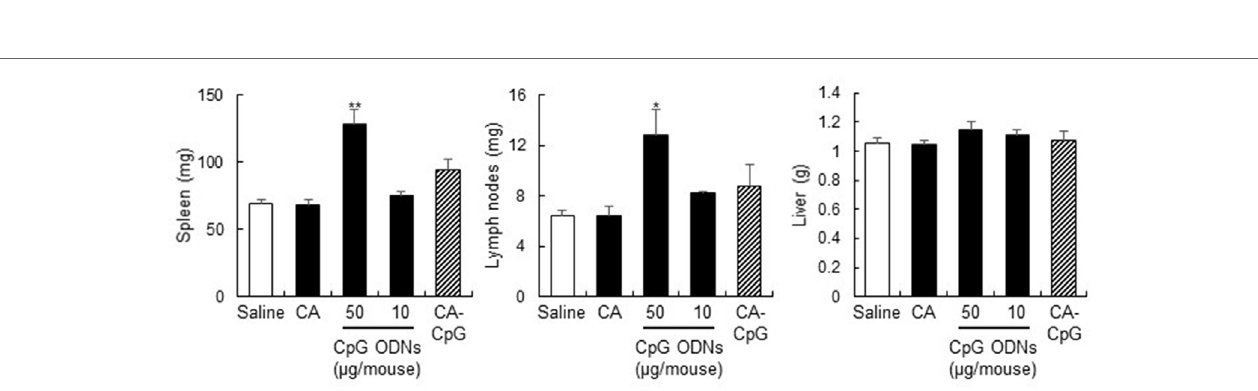
FigUre 7 | Adjuvant activities of carbonate apatite (CA)-cytosine-phosphate-guanine (CpG) in IFN- α / β receptor 2 (Ifnar2) and Il-12 p40 double-deficient mice (DKO mice). Wild-type (WT) mice or DKO mice were immunized subcutaneously at the base of the tail with ovalbumin (OVA) plus CA-CpG (10 µg CpG/mouse) at days 0 and 14. (a) OVA-specific antibody responses. Levels of OVA-specific total IgG, IgG1, and IgG2c in plasma were evaluated by ELISA 7 days after the final immunization, n = 5 per WT group and n = 4 per DKO group. (B) CD8 + cytotoxic T lymphocyte (CTL) responses. OVA 257–264 -specific CD8 + CTL responses were monitored in mice by tetramer assay 7 days after the final immunization, n = 5 per WT group and n = 4 per DKO group.